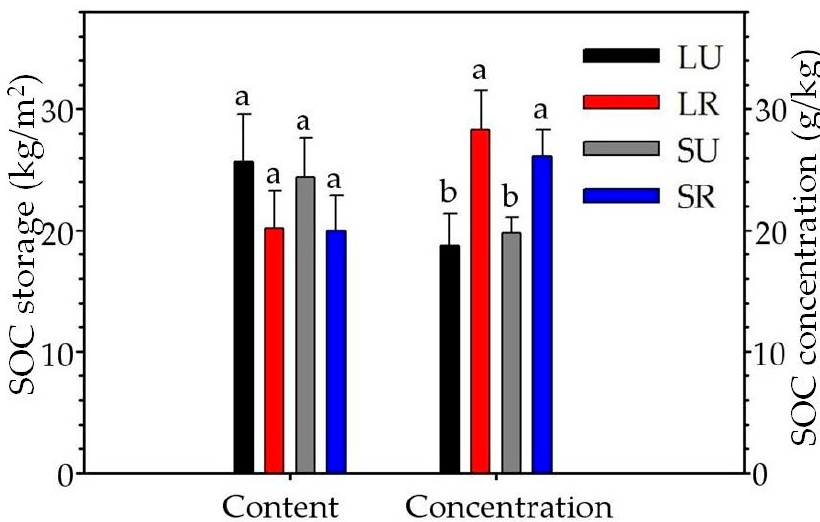
Figure 5. Exponential decay of soil organic carbon (SOC) concentration with soil depth in the four soil profiles (LU, LR, SU and SR) in a montane subtropical moist forest of southwestern China. Error bars indicate one standard error.